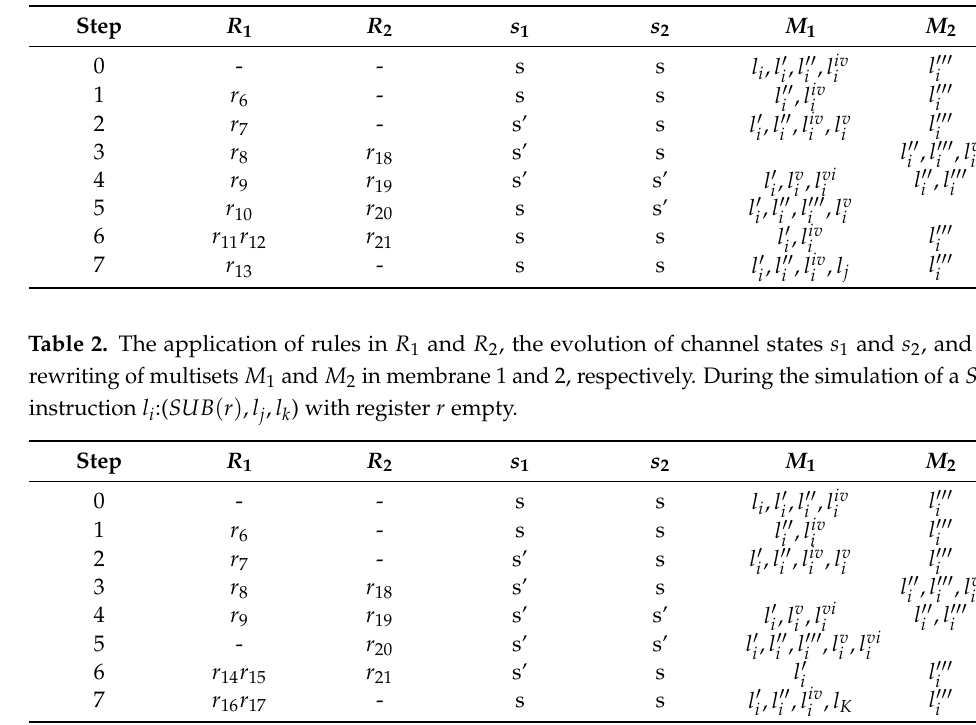
Accordingly, the SUB instruction of M is correctly simulated by the system Π